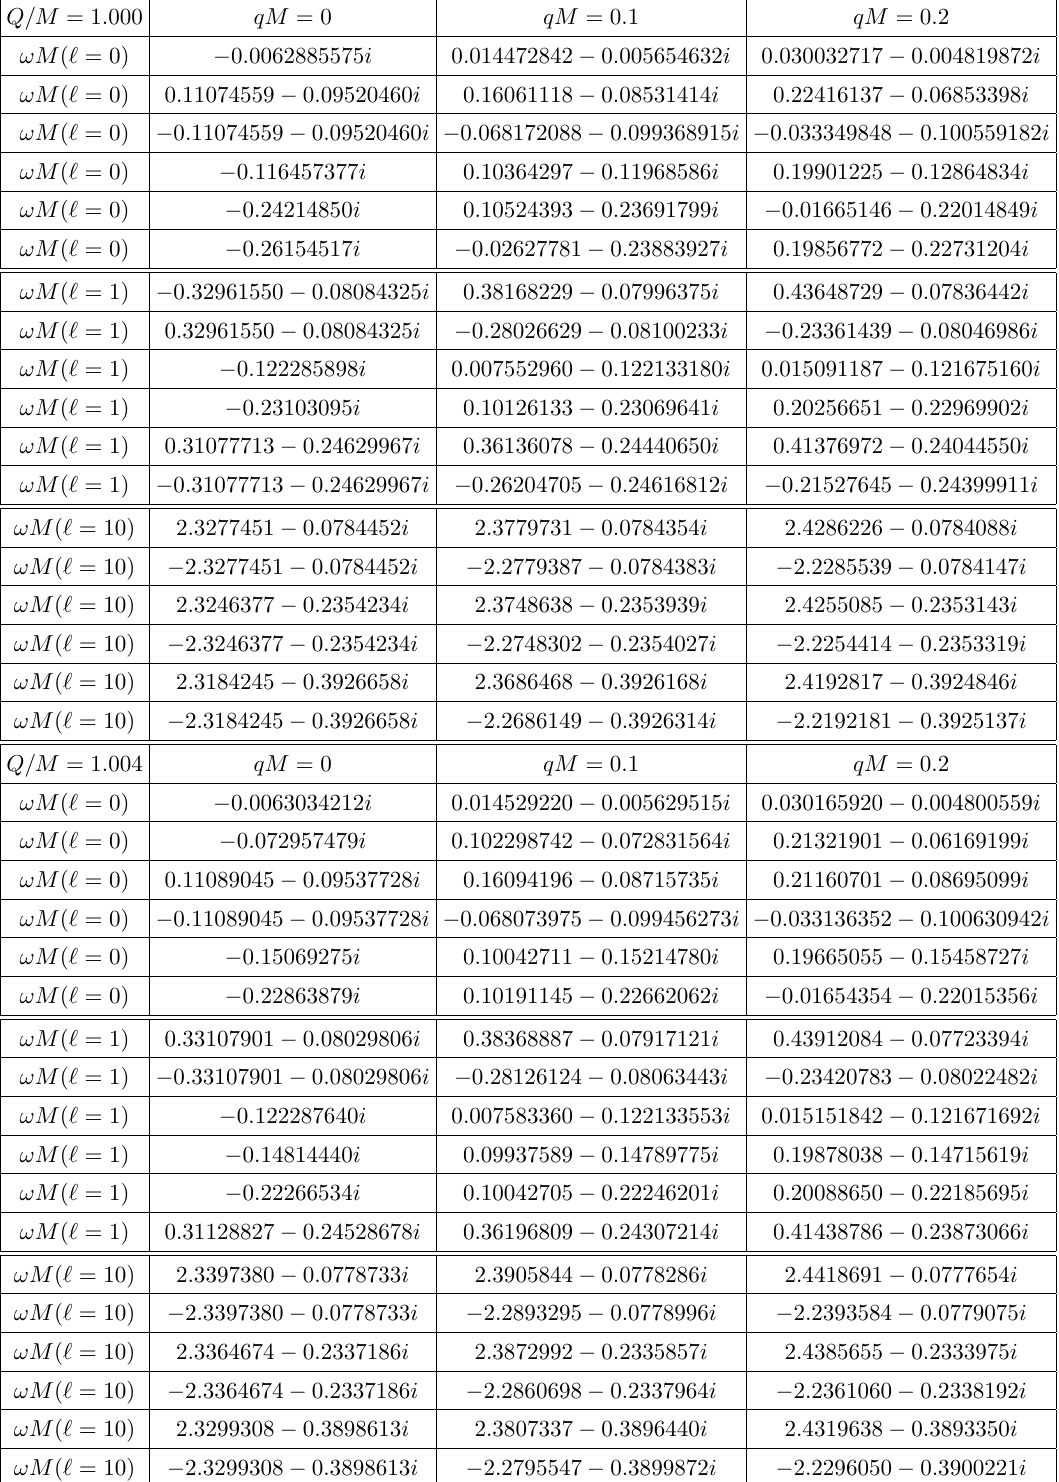
Table 14 . The QNFs ωM for massive ( mM = 0 . 05 ) scalar fields in the background of RNdS black holes with Λ M 2 = 0 . 04 , and different values of ‘ , and qM . Here, for Q/M = 1 , ∆ r/M ≈ 0 . 248 , and for Q/M = 1 . 004 , ∆ r/M ≈ 0 . 163 , with ∆ r/M = ( r H − r C ) /M . For Q/M = 1 . 008 two complex roots appear for f ( r )